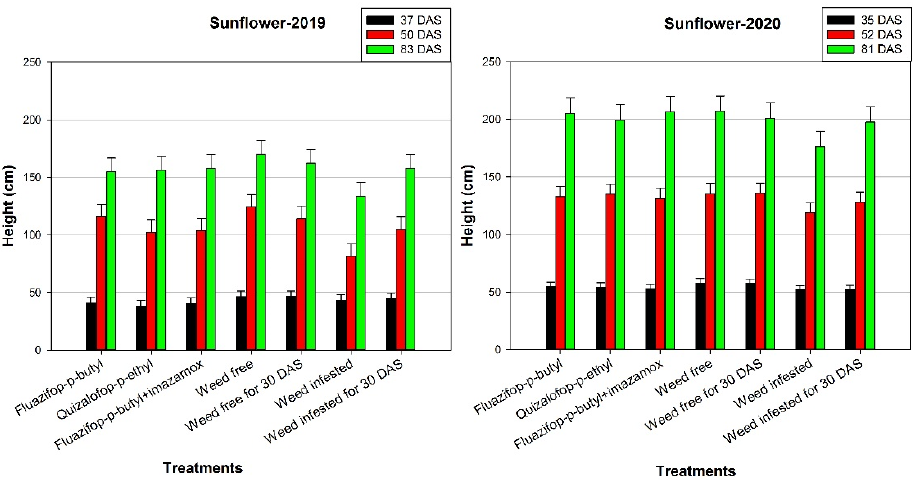
Figure 3. Effects of various control treatments of Johnsongrass on height (cm) of sunflower plants at different days after sowing (DAS), in 2019 and 2020. For each sampling date, error bars indicate the LSD 5% value.